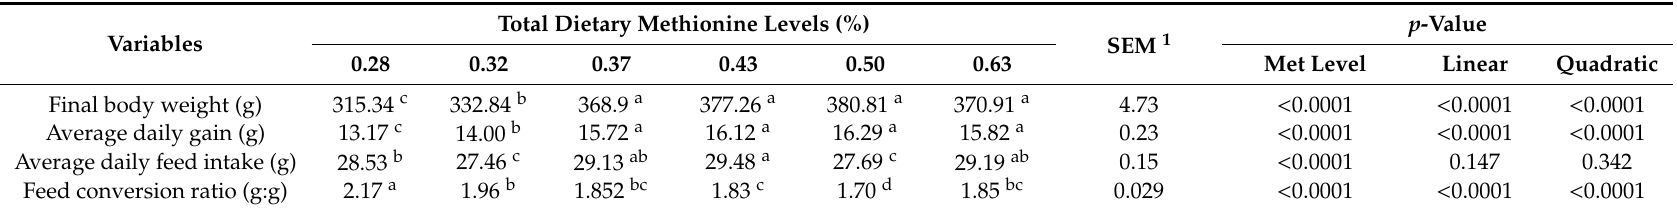
Table 3. E ff ects of total dietary methionine level on growth performance of female Lingnan yellow-feathered chickens aged 1–21 days.